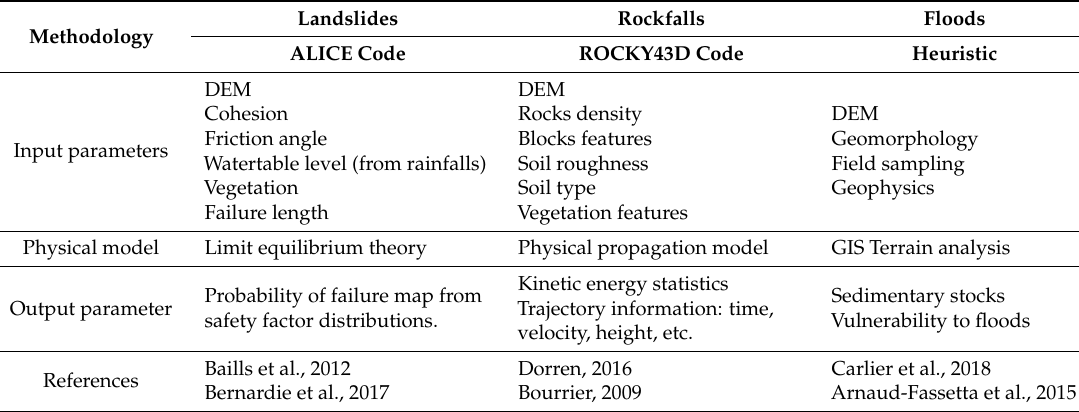
Table 1. Methodologies used to assess the landslides, rockfalls, and floods hazards, with related input/output parameters, physical approaches, and bibliographic